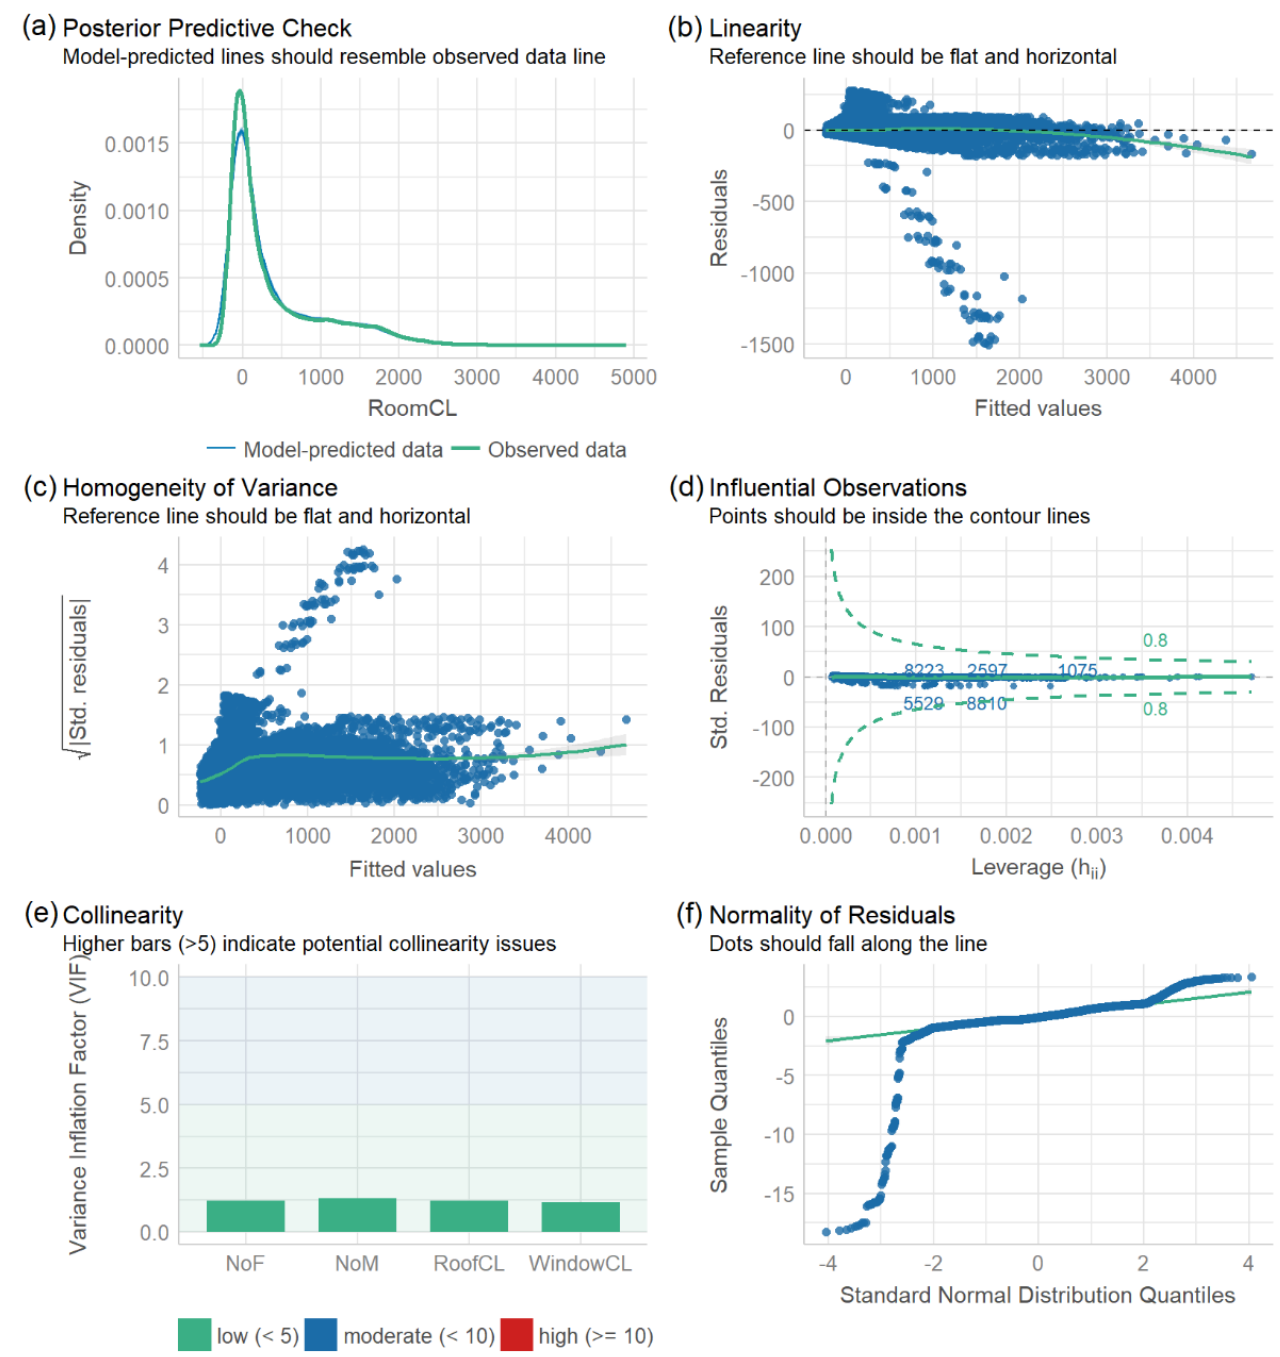
Figure 5. Visual check of model ’ s assumptions for all-seasons dataset: ( a ) posterior predictive check; ( b ) linearty; ( c ) homogeneity of variance; ( d ) influential observations; ( e ) collinearity; ( f ) normality of residuals.